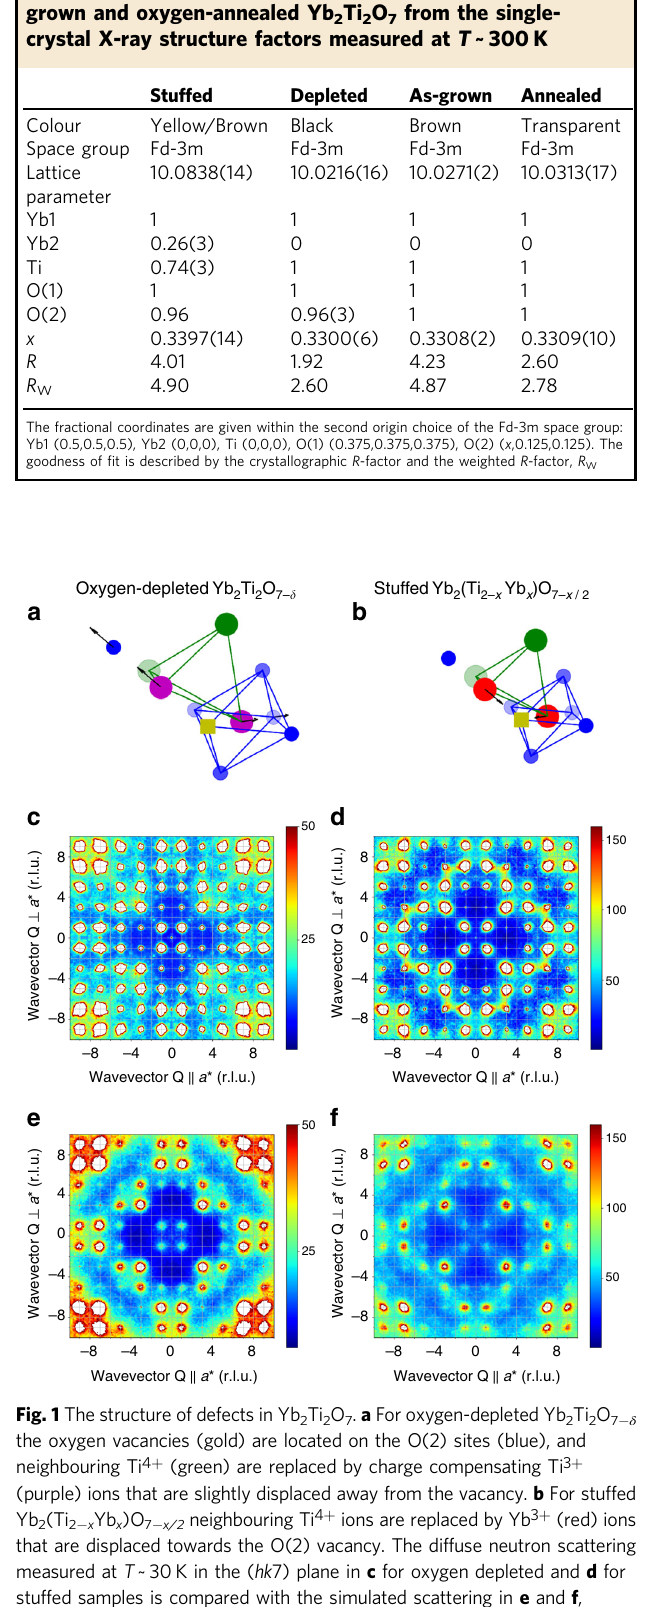
Table 1 Re fi nement of the average structures of stuffed